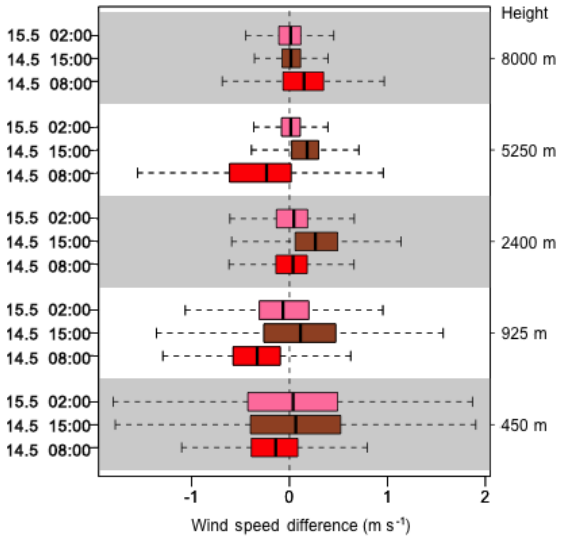
Figure 14. Wind speed differences between HR and HR_RESHIFT in domain 2.